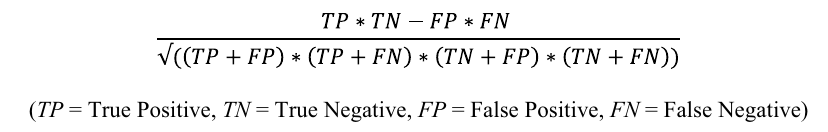
Fig. 1 Matthew’s correlation coefficient